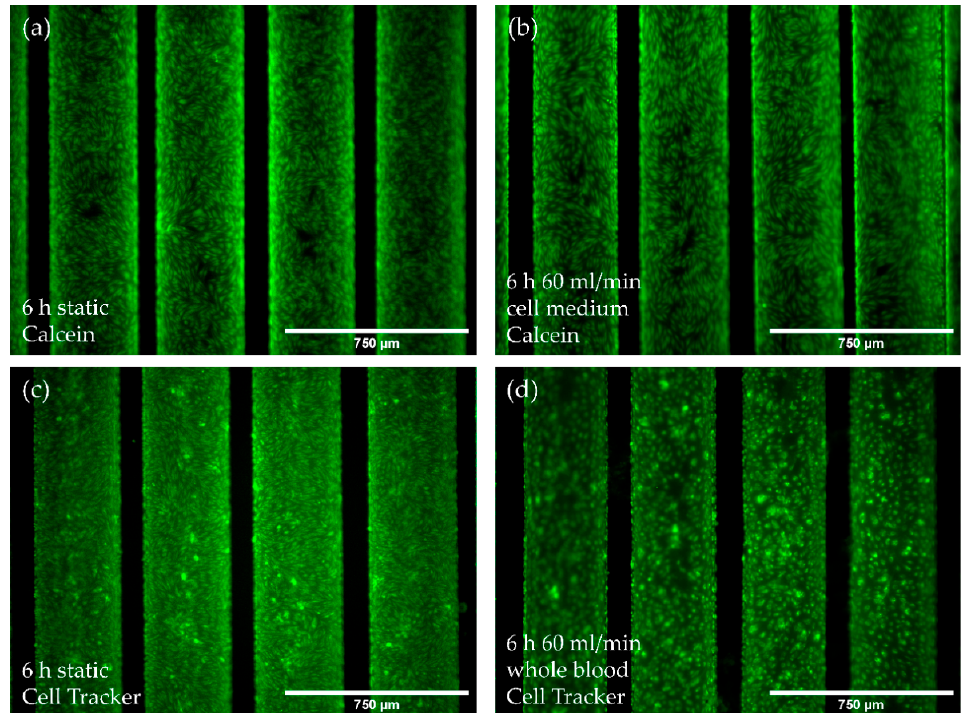
Figure 5. Analysis of EC monolayer integrity after culture medium or blood flow exposure for six hours. ( a , b ) Calcein staining (green) of pCECs on HFMs that ( a ) were kept statically or were exposed to ( b ) flow conditions using culture medium (60 mL/min); ( c , d ) Cell Tracker staining (green) of pCECs on statically cultivated HFMs ( c ) or on 60 mL/min blood flow exposed HFMs ( d ).